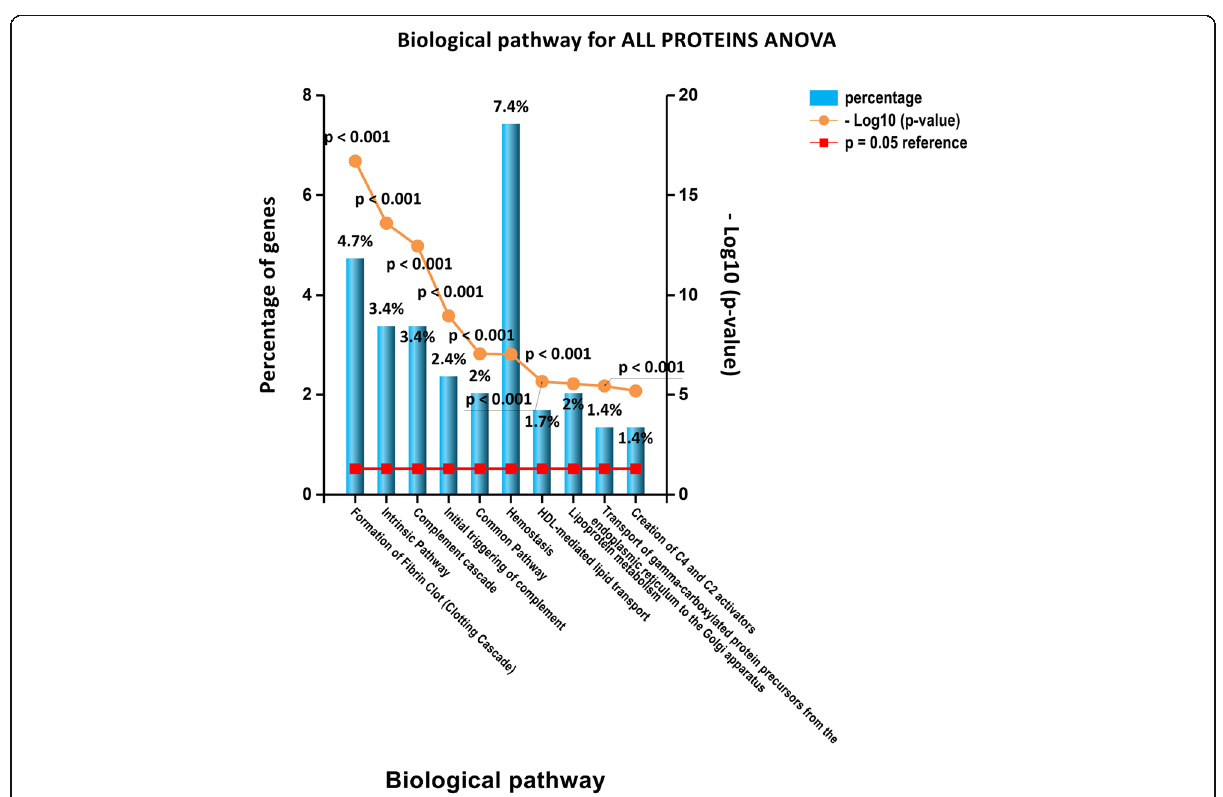
Fig. 2 Pathway analysis was performed by FunRich 3.0 program. All the proteins passing the cutoff of ANOVA p value < 0.05 were considered for biological pathway enrichment. The list of pathways obtained was sorted by – log10 p value and only top 10 pathways are shown